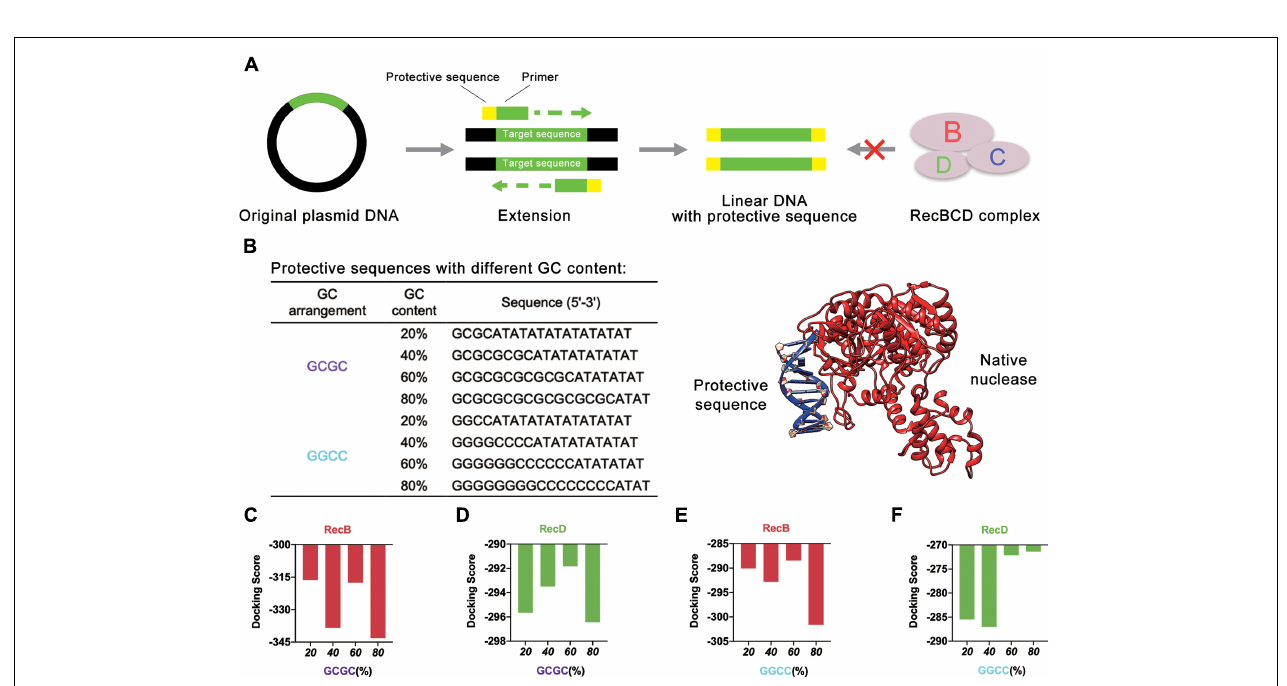
FIGURE 1 | Schematic diagram of the linear DNA design strategy for the optimization of LDET-based cell-free systems. The computer simulation was used to evaluate the effectiveness of the linear DNA design strategy. Cell-free experiments were carried out to verify the results of the computer simulation. This design strategy could help to promote the development of cell-free systems for various applications.